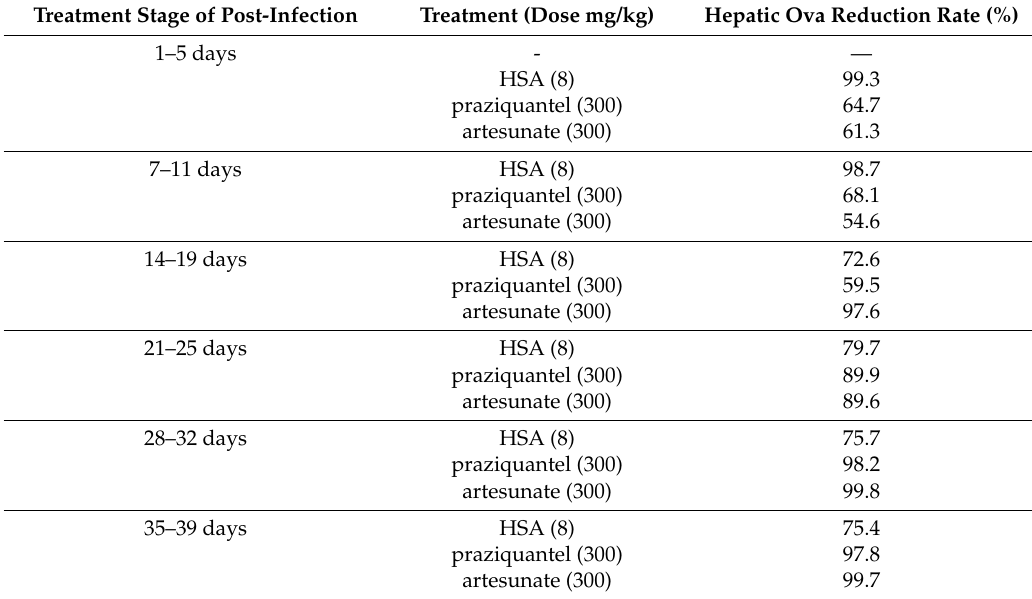
Table 4. Ova load in S. japonicum infected mice received HSA, praziquantel or artesunate treatment. Treatment Stage of